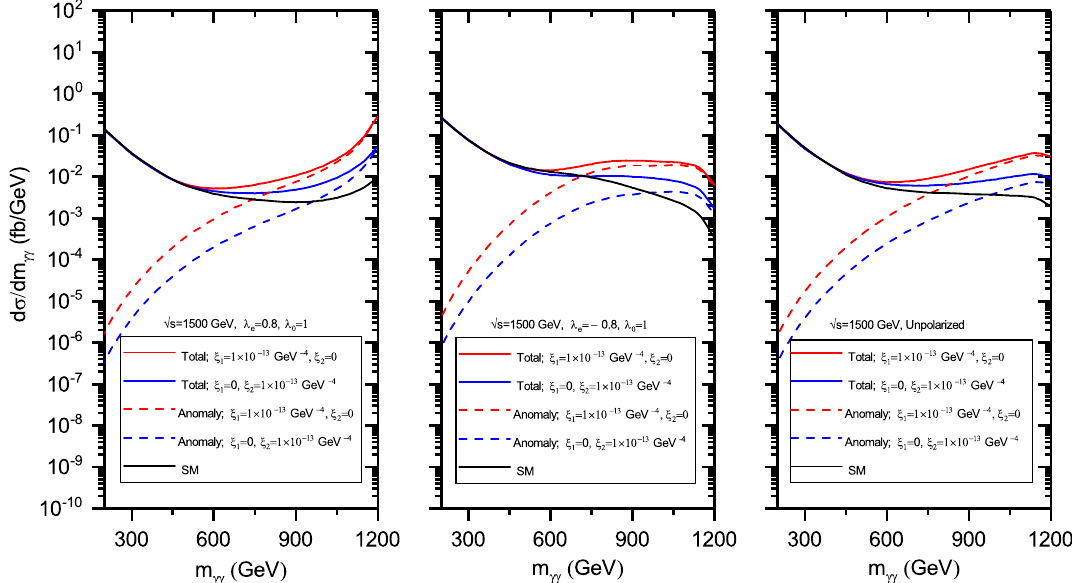
Fig. 2 The differential cross sections for the process γγ → γγ as functions of the invariant mass of the outgoing photons for the e + e − √ s = 1500GeV.Theleft,middleandrightpanelscorre- colliderenergy spond to the electron beam helicity λ e = 0 . 8 , − 0 . 8, and 0, respectively.